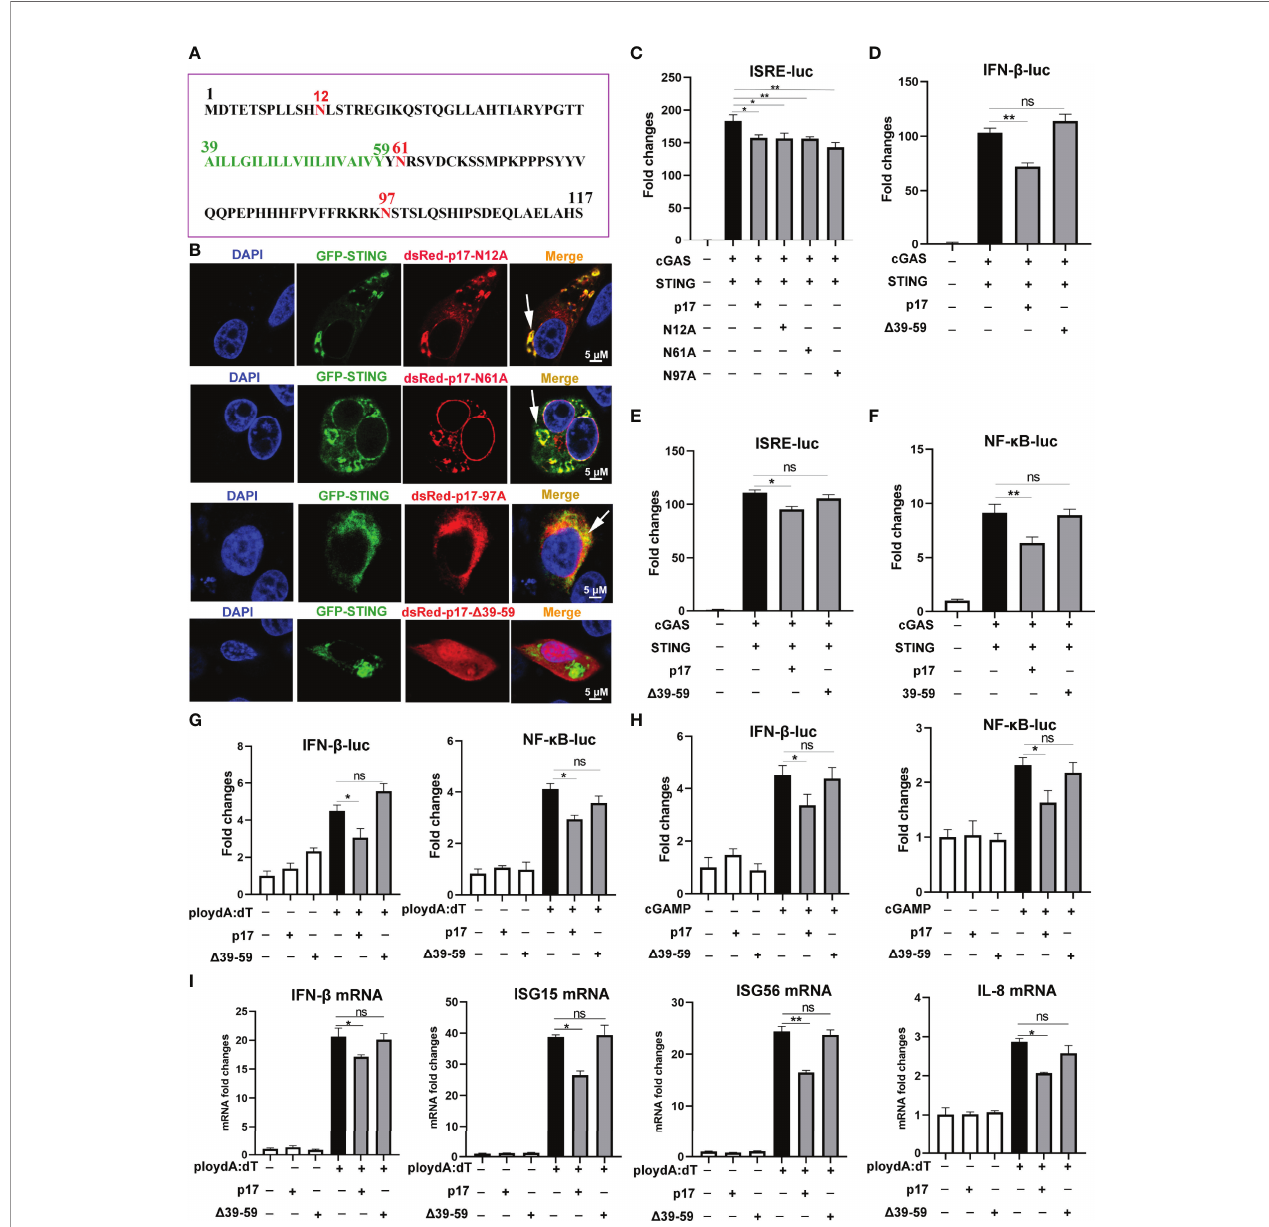
FIGURE 7 | The effects of p17 mutants on cGAS-STING signaling pathway. (A) The protein amino acid sequence of p17, which consists of 117 amino acids and includes three glycosylation sites (red marked N12, N17 and N97) and one transmembrane domain (green marked A39-Y59). (B) The co-localizations between STING and p17 N12A, N17A, N97A, △ 39-59 in transfected 3D4/21 cells were examined by confocal microscopy. The arrows represent the co-localized punctate patterns. (C) The effects of p17 N12A, N17A and N97A on the ISRE promoter activation triggered by transfected porcine cGAS-STING in 293T cells were measured by Double-luciferase reporter assay. (D – F) The effects of p17 △ 39-59 on the promoter activations of IFN- b , ISRE and NF- k B triggered by cGAS-STING pathway in transfected 293T cells. (G, H) The effects of △ 39-59 on the activations of promoter IFN- b and NF- k B triggered by transfection of polydA:dT (1 m g/mL) and cGAMP (2 m g/mL) in 3D4/21 cells. (I) The effect of △ 39-59 on the polydA:dT activated mRNA expressions of IFN- b , ISG15, ISG56 and IL-8 were assayed by RT-qPCR in 3D4/21 cells. Values represent the mean±S.D. * P <0.05, ** P <0.01, ns not signi fi